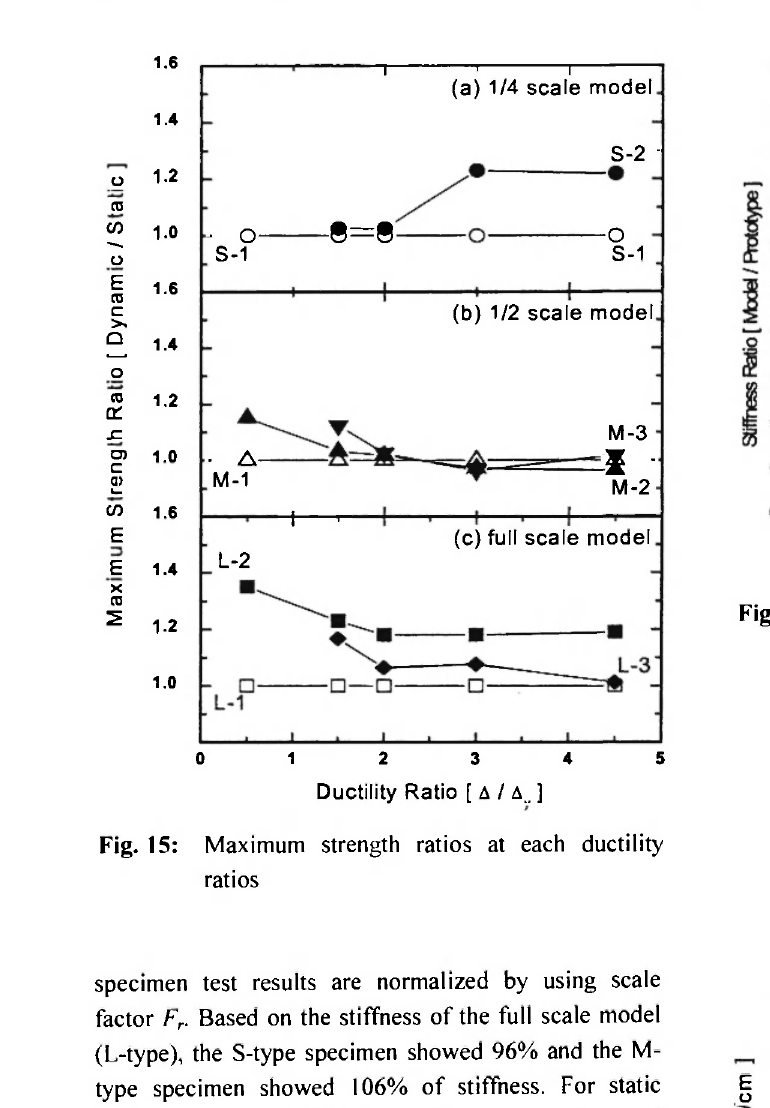
Fig. 16: Stiffness ratios for each different loading rates and specimen